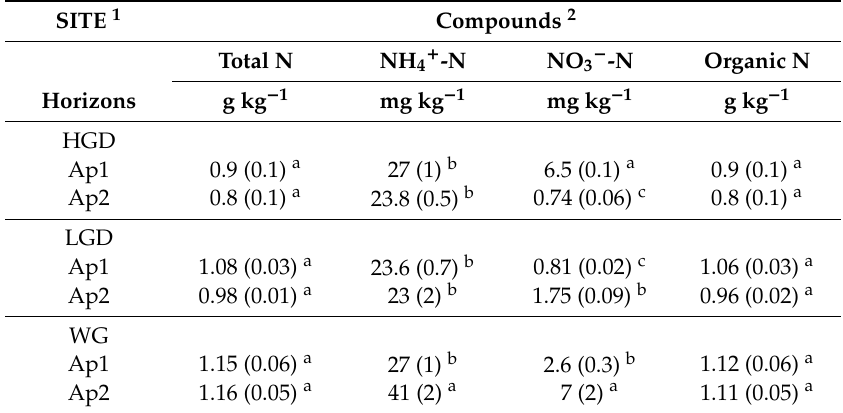
Table 3. Contents of total N, ammonium and nitrate of the vineyard soils with a high and low geese density, and of the soil of the control vineyard. Numbers in parentheses are the standard errors ( n =